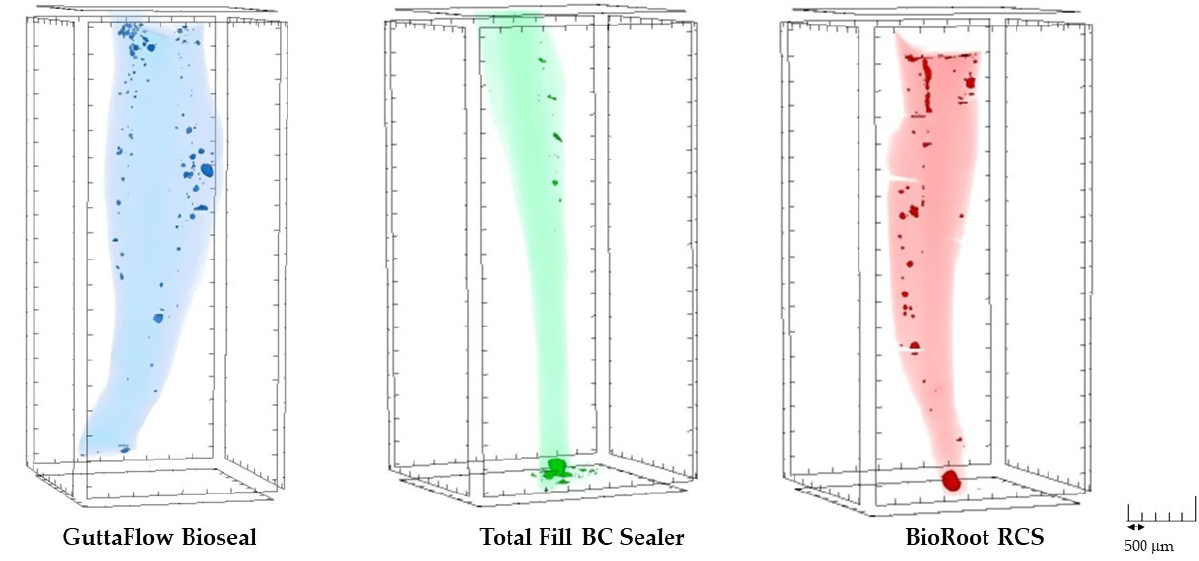
Figure 4. The three-dimensional (3D) reconstructions of the fillings of the random samples demon- strating different size and distribution of the pores through the filling materials.